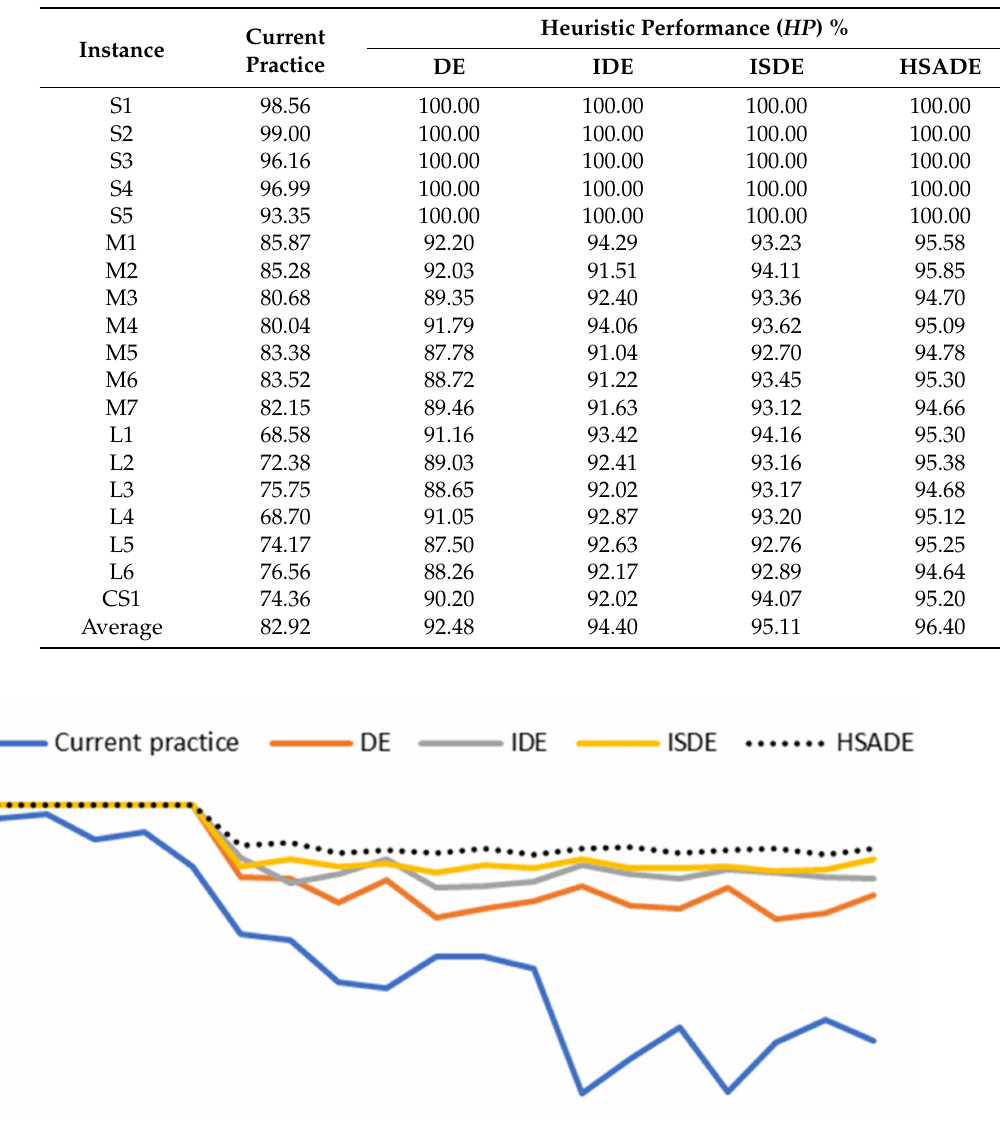
Table 6. The heuristic performance ( HP ) results for testing instances.